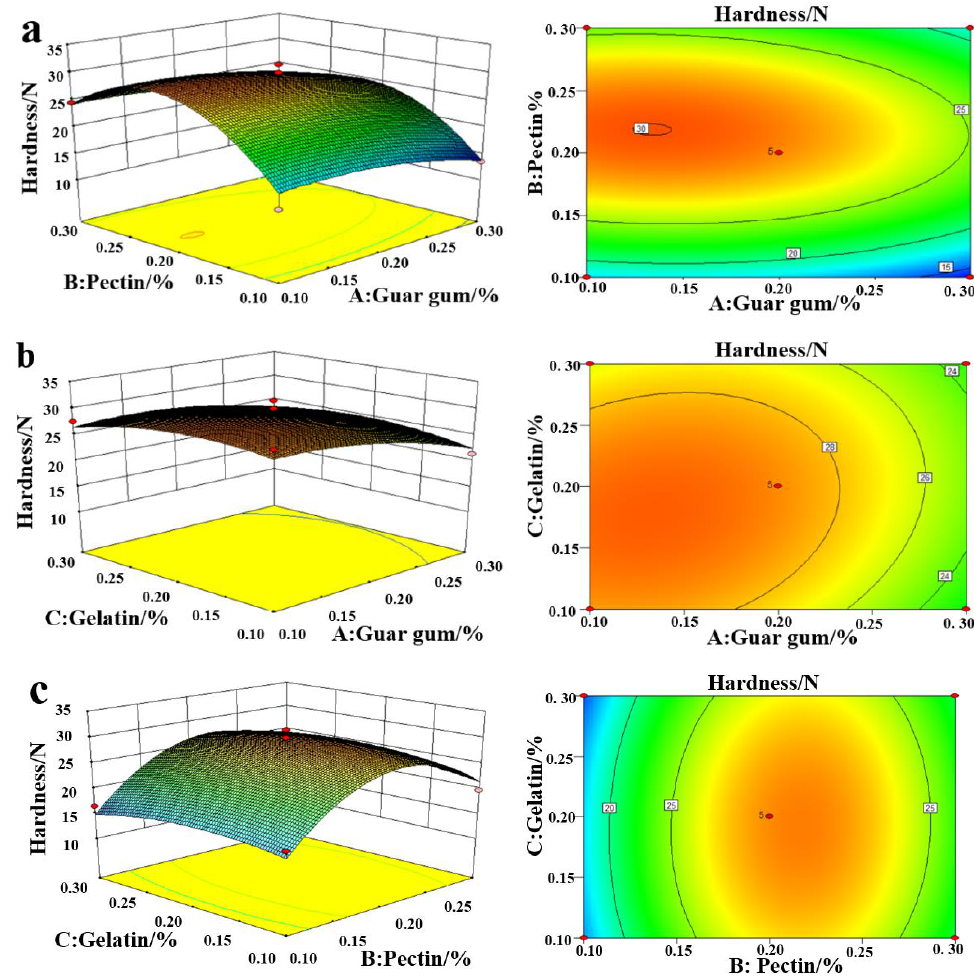
Figure 2. Response surface methodology of the interaction between guar gum and pectin ( a ), guar gum and gelatin ( b ), and pectin and gelatin ( c ) to hardness.